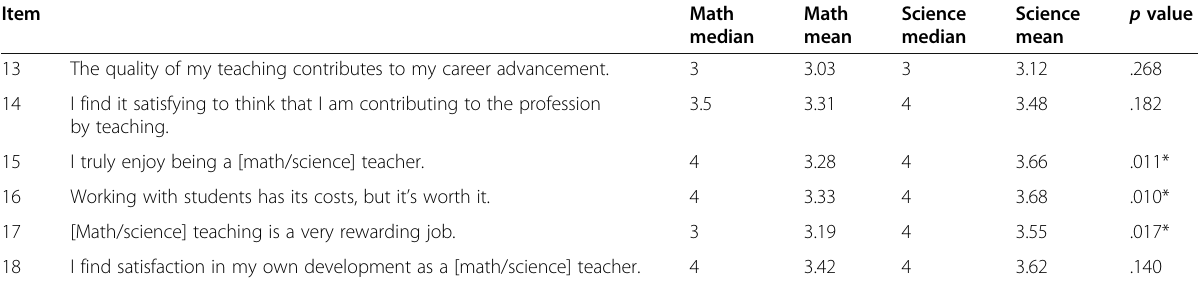
Table 5 Comparison of science and math teacher scores on items within the self-image factor Item